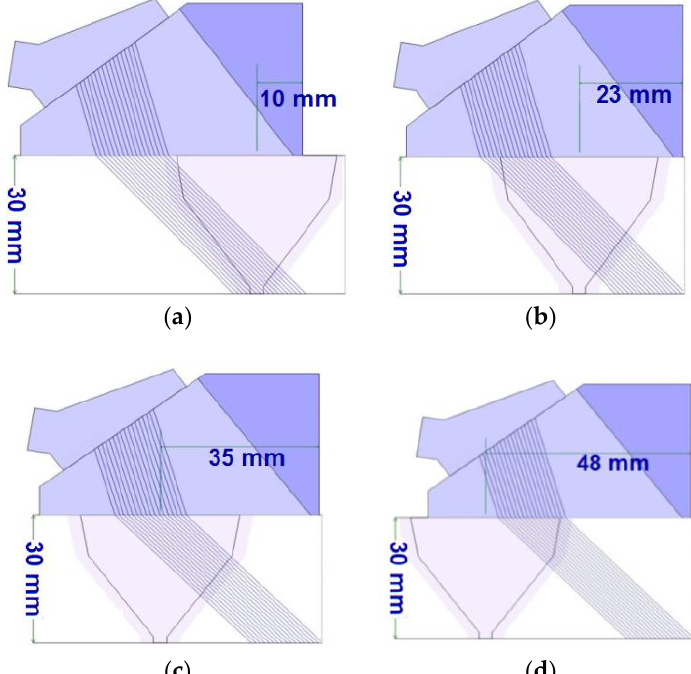
Figure 4. Simulation of inspection with scanning angle of 45° and 16 active elements. Indexes: ( a ) 10 mm, ( b ) 23 mm, ( c ) 35 mm and ( d ) 48 mm.